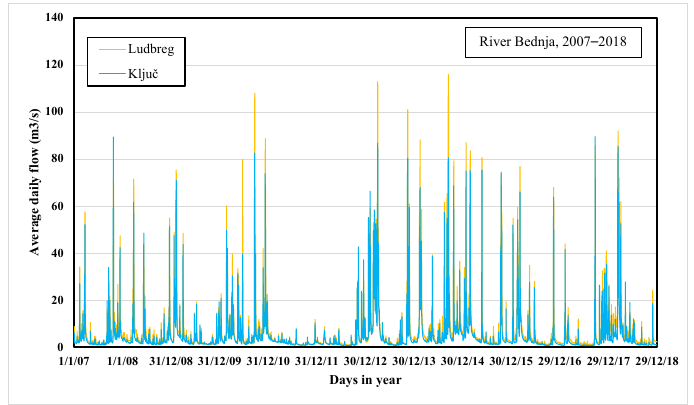
Figure 8. Comparison of the average daily flows for the measuring stations Ludbreg and Klju č .